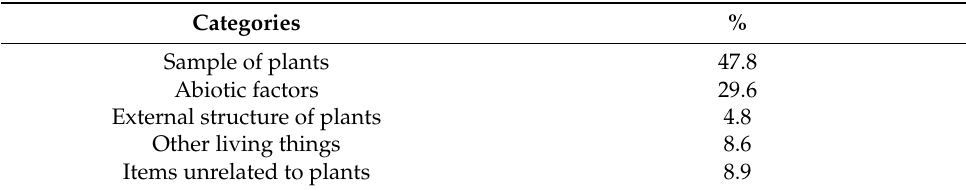
Table 2. Relative frequencies (%) of pictorial elements broken down by pictorial categories in the whole sample ( n = 140).